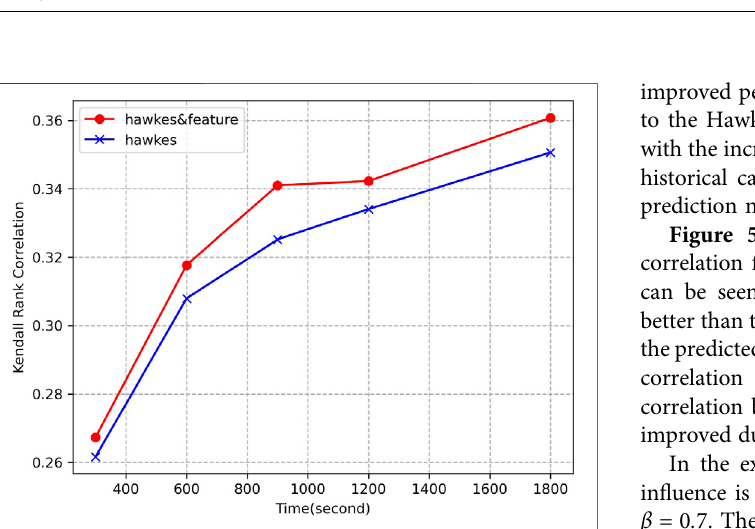
FIGURE 4 | Comparison of APE of two models on dataset 1. (A) Evolutionary trend of the median APE with prediction time t , (B) Evolutionary trend of mean APE with prediction time t .